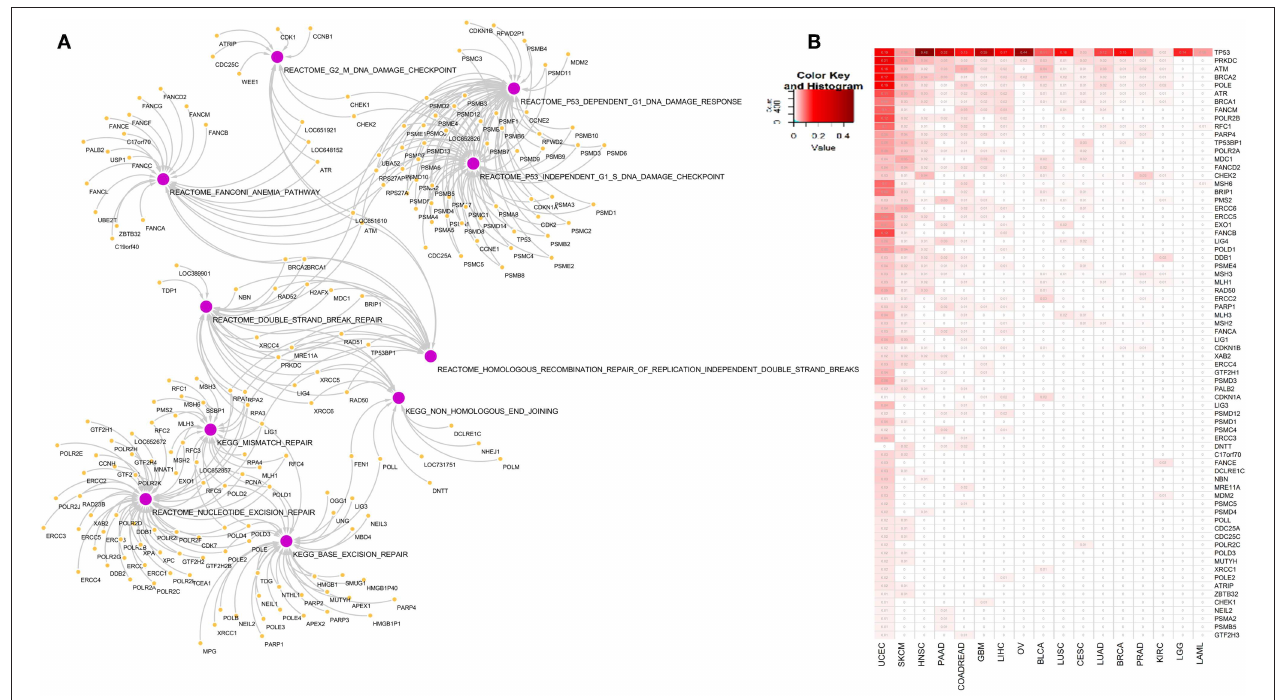
FIGURE 1 | (A) Network diagram of genes associated with 10 DNA damage response pathways at different level of DNA repair: base excision repair, nucleotide excision repair, mismatch repair, double strand break repair, homologous recombination repair of replication independent DNA double strand breaks, non-homologous end joining, G2-M DNA damage checkpoint, Fanconi anemia pathway, P53 dependent DNA damage response and P53 independent DNA damage response. (B) Somatic mutations in genes from the 10 DNA damage response pathways in 17 cancer types. We included genes that are mutated in at-least 1% of tumor samples in more than one tumor types. Numbers in each cell represents frequency of samples carrying mutation in corresponding gene in that cancer type. Rows and columns are sorted by the frequency of mutation of the DDR genes in the tumor